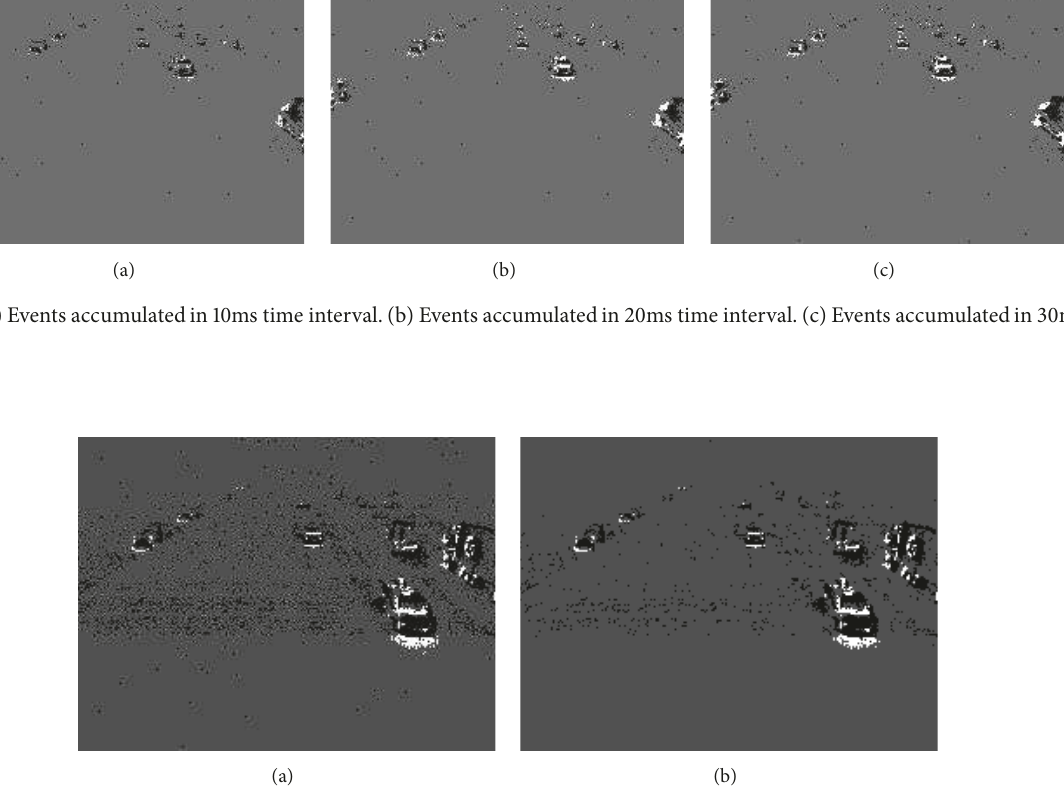
Figure 4: Background activity filter. (a) Events accumulated in 20ms time interval prior to filtering. (b) Events accumulated in 20ms time interval after filtering. This figure is adopted from